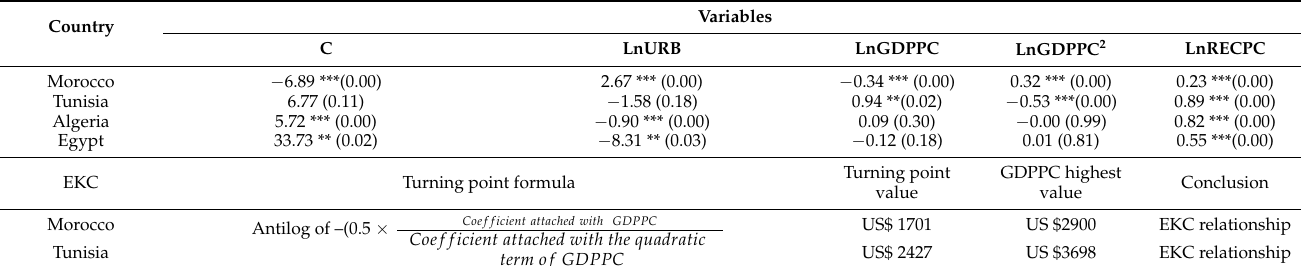
Table 5. Long-run elasticities; the dependent variable is Ln RCO 2 PC emissions.